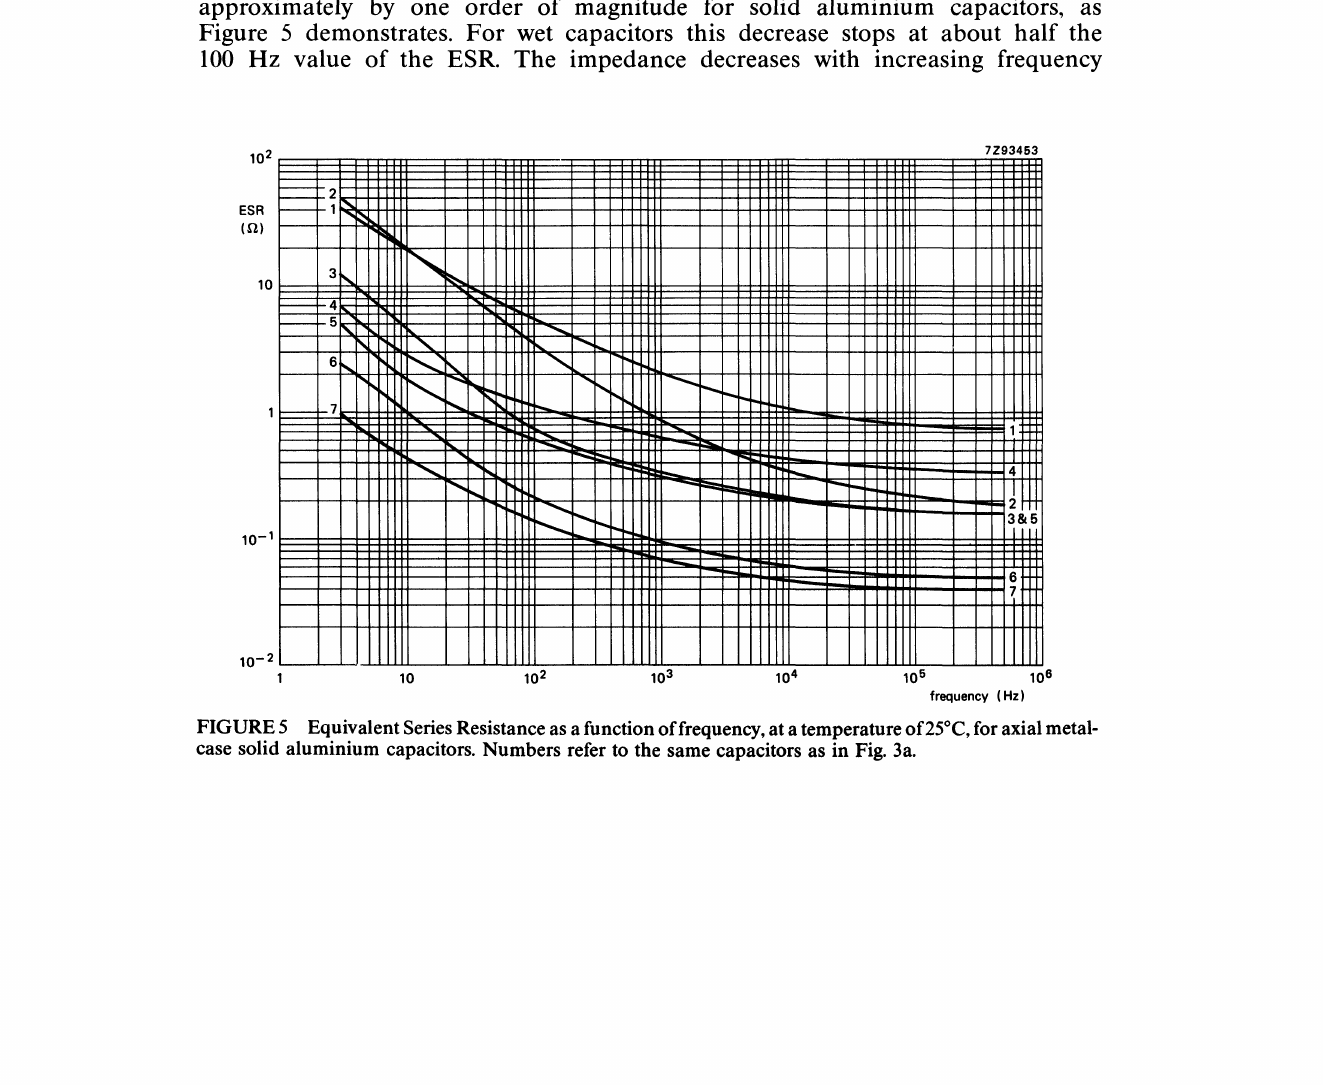
FIGURE 5 Equivalent Series Resistance as a function of frequency, at a temperature of 25C, for axial metal- case solid aluminium capacitors. Numbers refer to the same capacitors as in Fig.